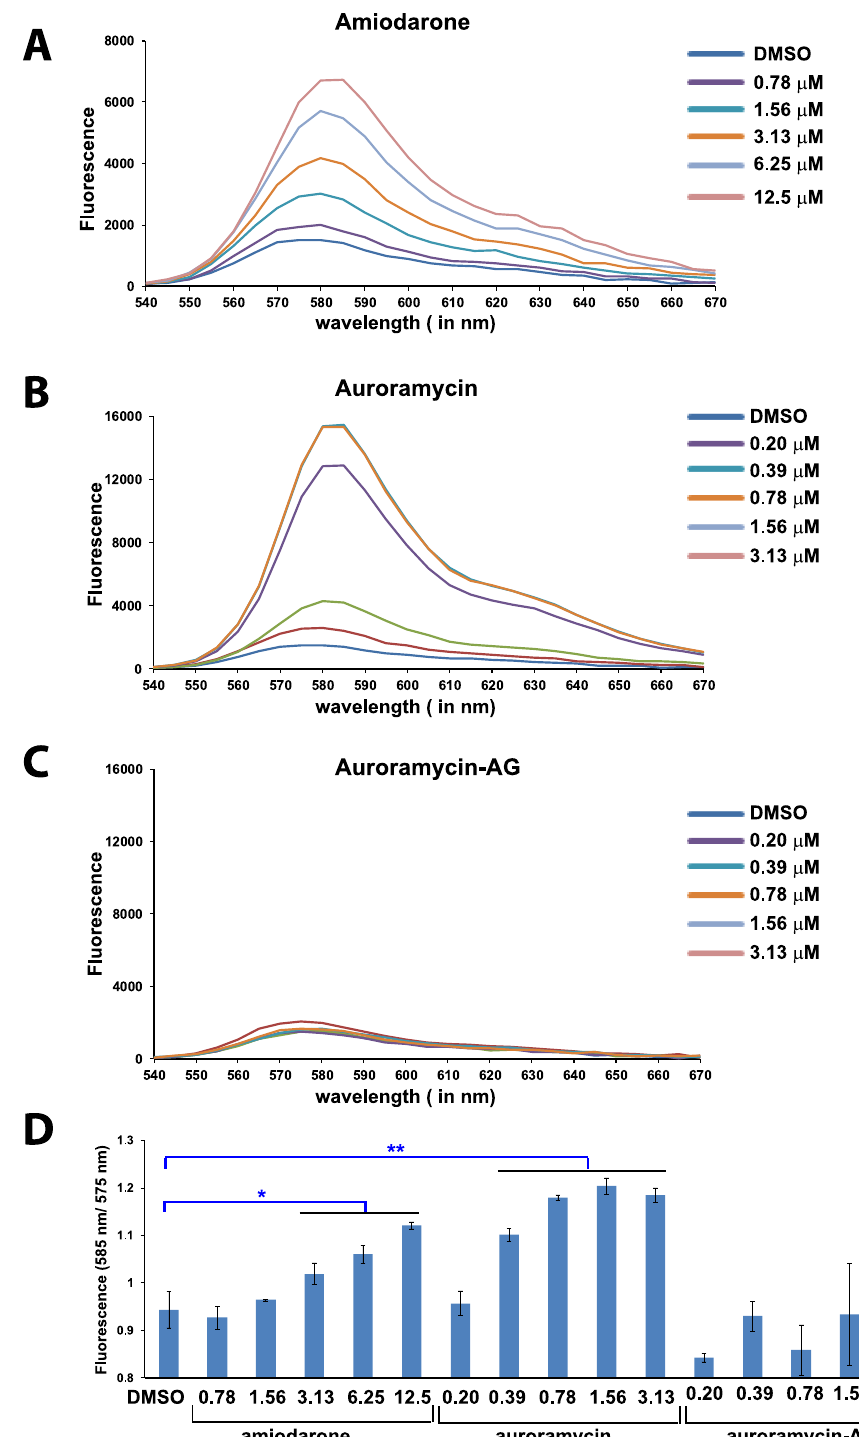
Fig 10. Auroramycin causes hyperpolarization of yeast cells. (A)diS-C 3 (3) fluorescence of wild type AH109 yeast cells suspensions at different concentrations of amiodarone. (B)diS-C 3 (3) fluorescence of wild type AH109 yeast cells suspensions at different concentrations of auroramycin. (C)diS-C 3 (3) fluorescence of wild type AH109 yeast cells suspensions at different concentrations of auroramycin-aglycon. (D)Ratio of fluorescence at 585 nm to 575 nm is plotted for various cultures treated in A-C. Error bars (n = 3 Mean ± S.D) are indicated in the plot. Asterisks